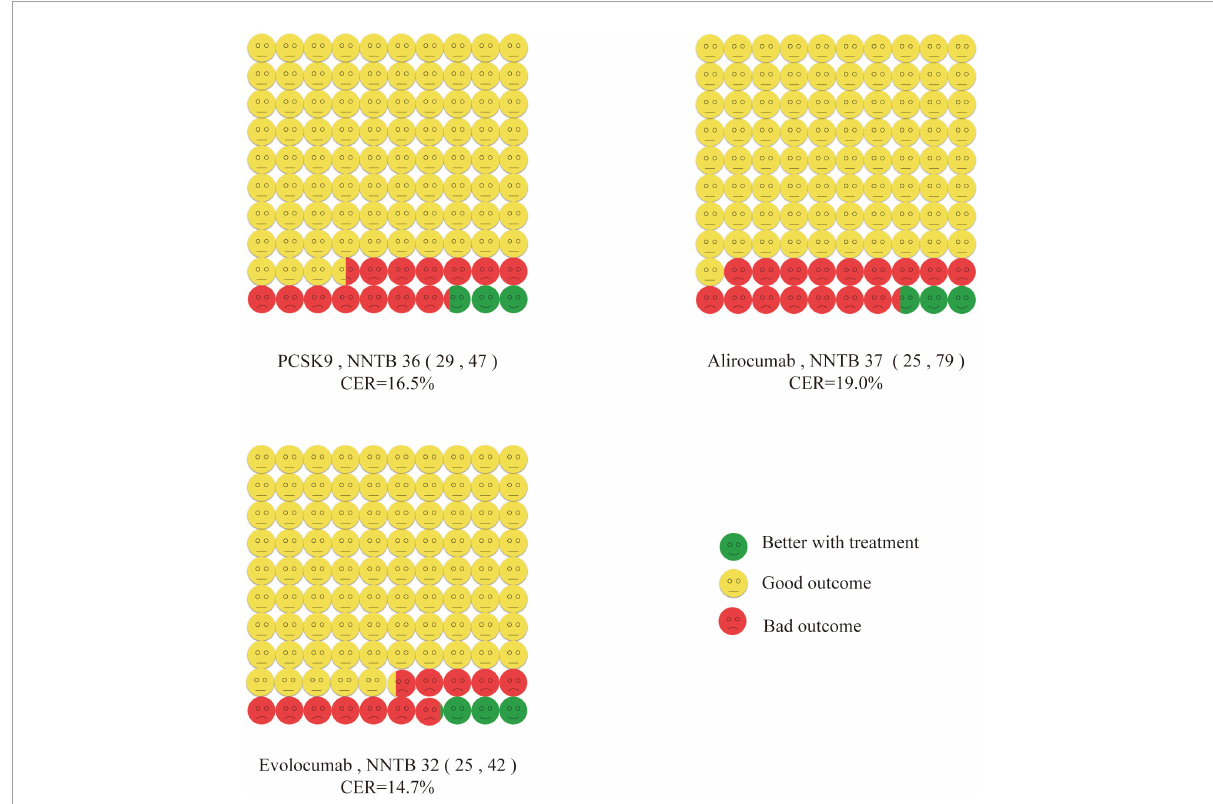
FIGURE3 Cates plot. The effect of PCSK9 inhibitors in major adverse cardiovascular events is shown. 100 smiley faces represent 1,000 participants treated with PCSK9. Green face means no major adverse cardiovascular events if treated with PCSK9. Yellow face means no major adverse cardiovascular events even if not treated with PCSK9. Red face means major adverse cardiovascular events will occur even if treated with